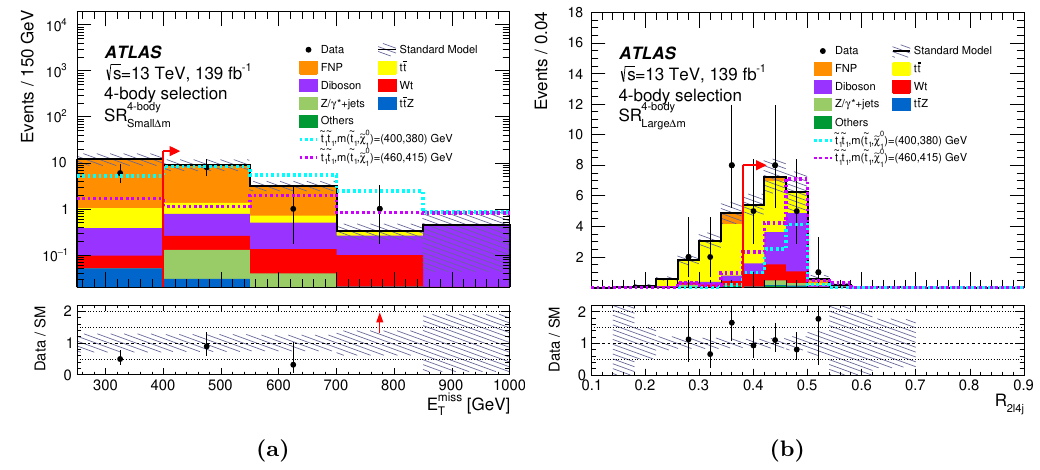
Figure 13 . Four-body selection. (a) distributions of E miss in SR 4-body and (b) distribution of T Small ∆ m R in SR 4-body for events satisfying the selection criteria of the given SR, except the one for 2 ‘ 4 j Large ∆ m the presented variable, after the background fit. The contributions from all SM backgrounds are shown as a histogram stack. “Others” includes contributions from V V V , tt t , tttt , tt W , tt WW , tt WZ , tt H , and tZ processes. The hatched bands represent the total statistical and systematic uncertainty. The rightmost bin of each plot includes overflow events. Reference top squark pair production signal models are overlayed for comparison. Red arrows in the upper panel indicate the signal region selection criteria. The bottom panels show the ratio of the observed data to the total SM background prediction, with hatched bands representing the total uncertainty in the background prediction; red arrows show data outside the vertical-axis